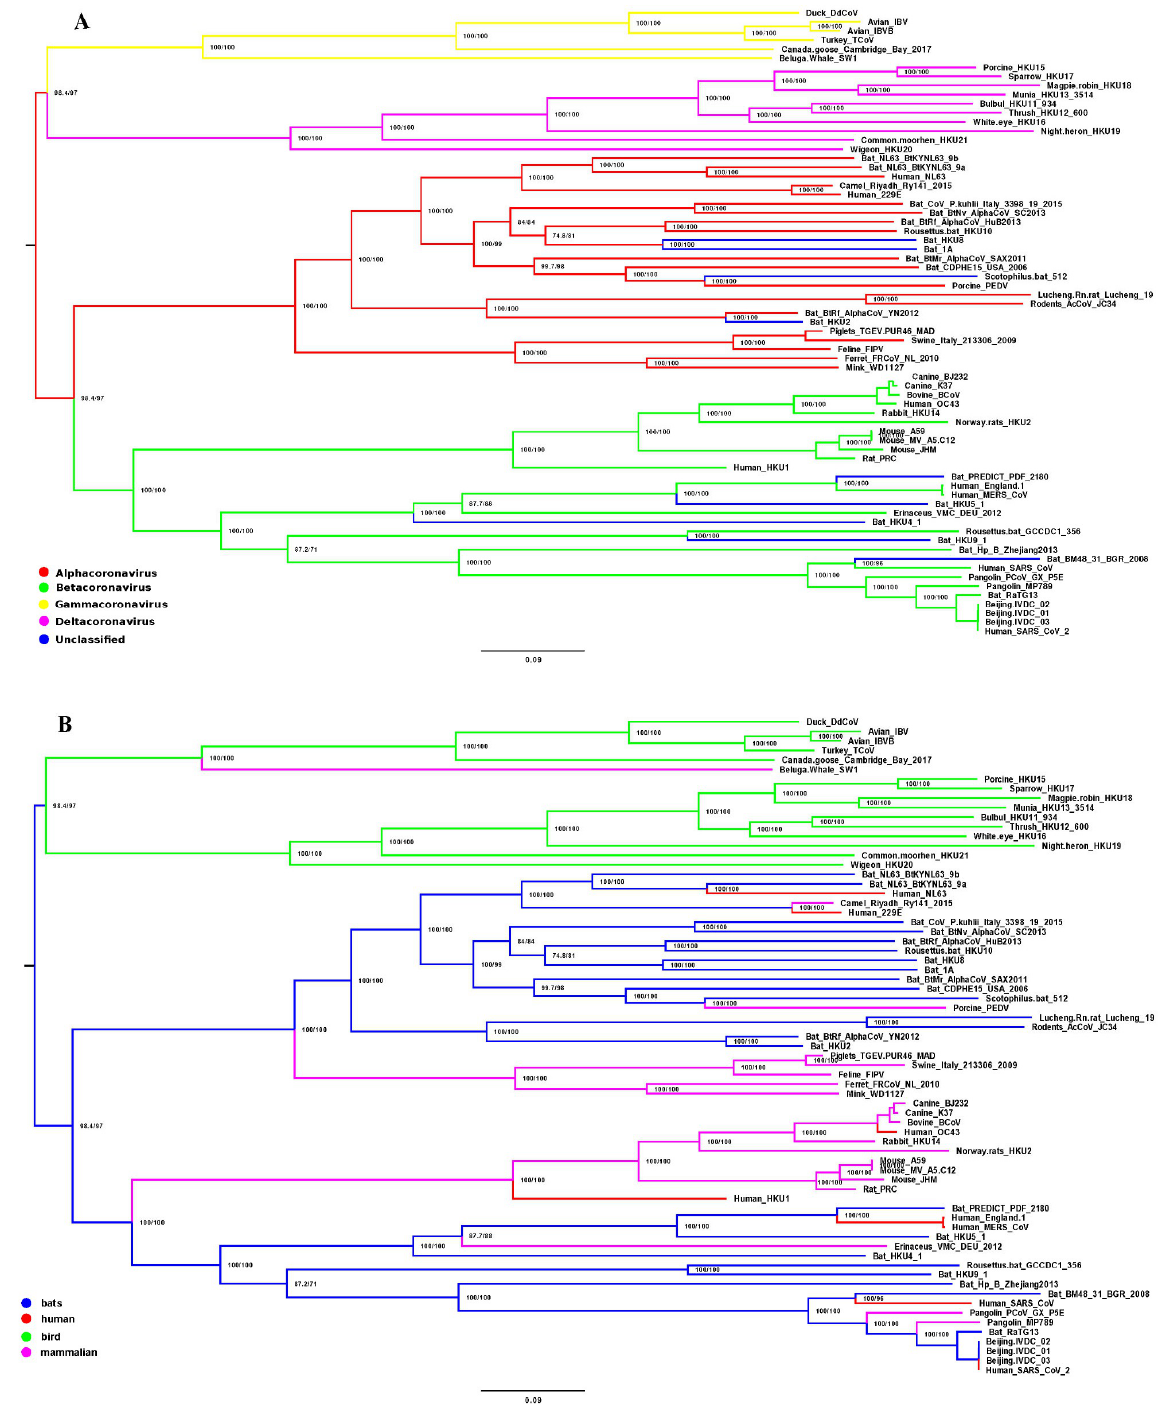
Fig 1. Phylogenetic tree based on the alignment of 69 whole genome coronavirus sequences. Different colors highlight taxonomic affiliation of the coronaviruses (A) and the type of the disease caused by them (B).